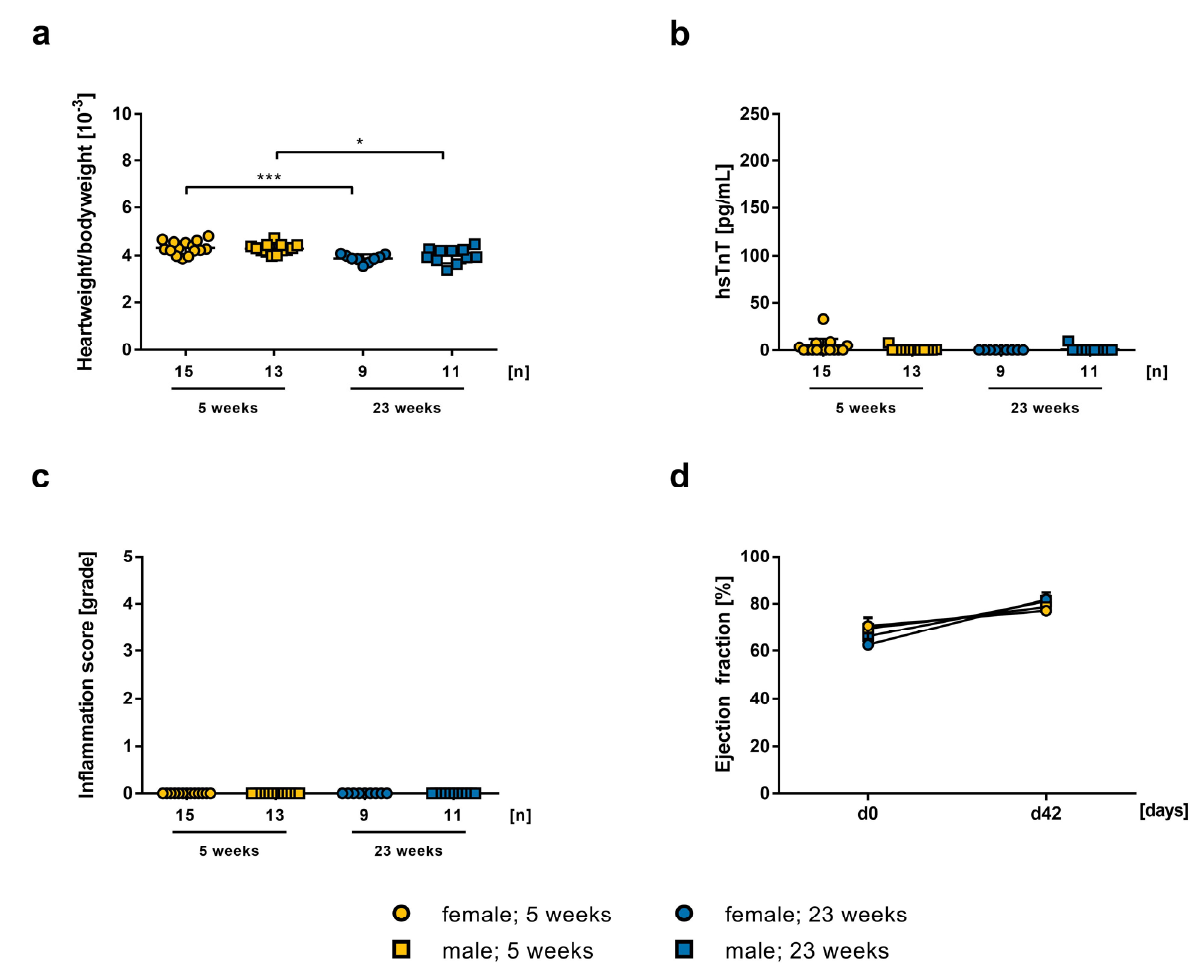
Figure 1. Effect of 0.2 µg mRNA-vaccine on 5–7 weeks old female (n = 15) and male (n = 13), and on 23-weeks old female (n = 9) and male (n = 11) A/J wt mice. Data is presented as a mean ± SEM. ( a ) Calculated heart weight to body weight ratio on day 42. Statistical significance was determined by one-way ANOVA: * p = 0.0358, *** p = 0.0007. ( b ) Evaluation of hsTnT-levels in mouse serum collected on day 42. ( c ) Histopathological examination of inflammation score in grades in HE stained heart sections on day 42, evaluated by two independent investigators. ( d ) Echocardiographic examination of ejection fraction using M-mode on day 0 and day 42.